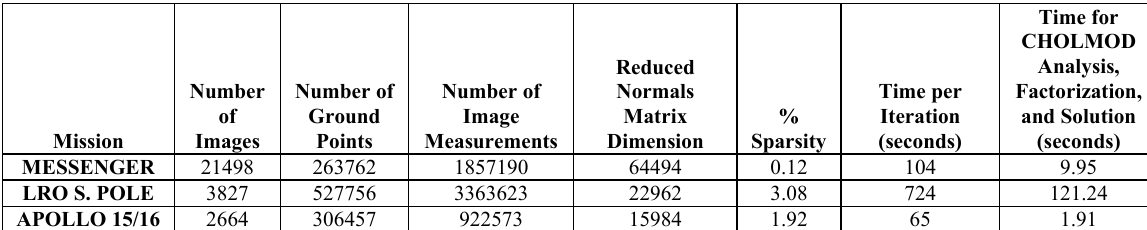
Table 1: Jigsaw bundle adjustment times for iteration and sparse matrix solution.